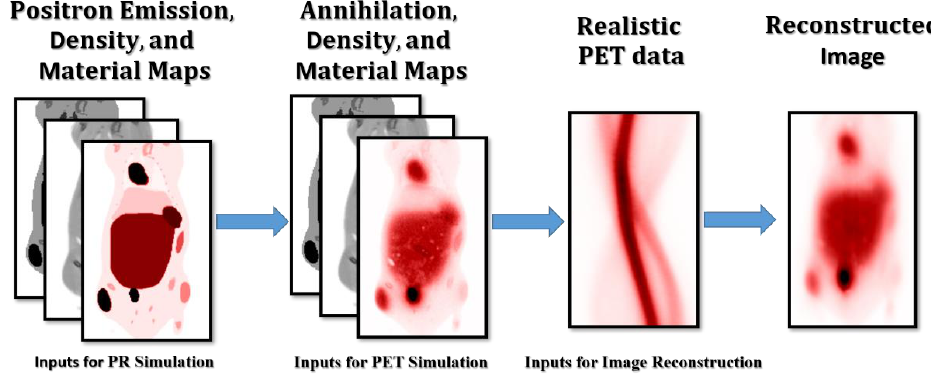
Figure 2. Workflow used to produce the realistic simulated cases with different radionuclides.